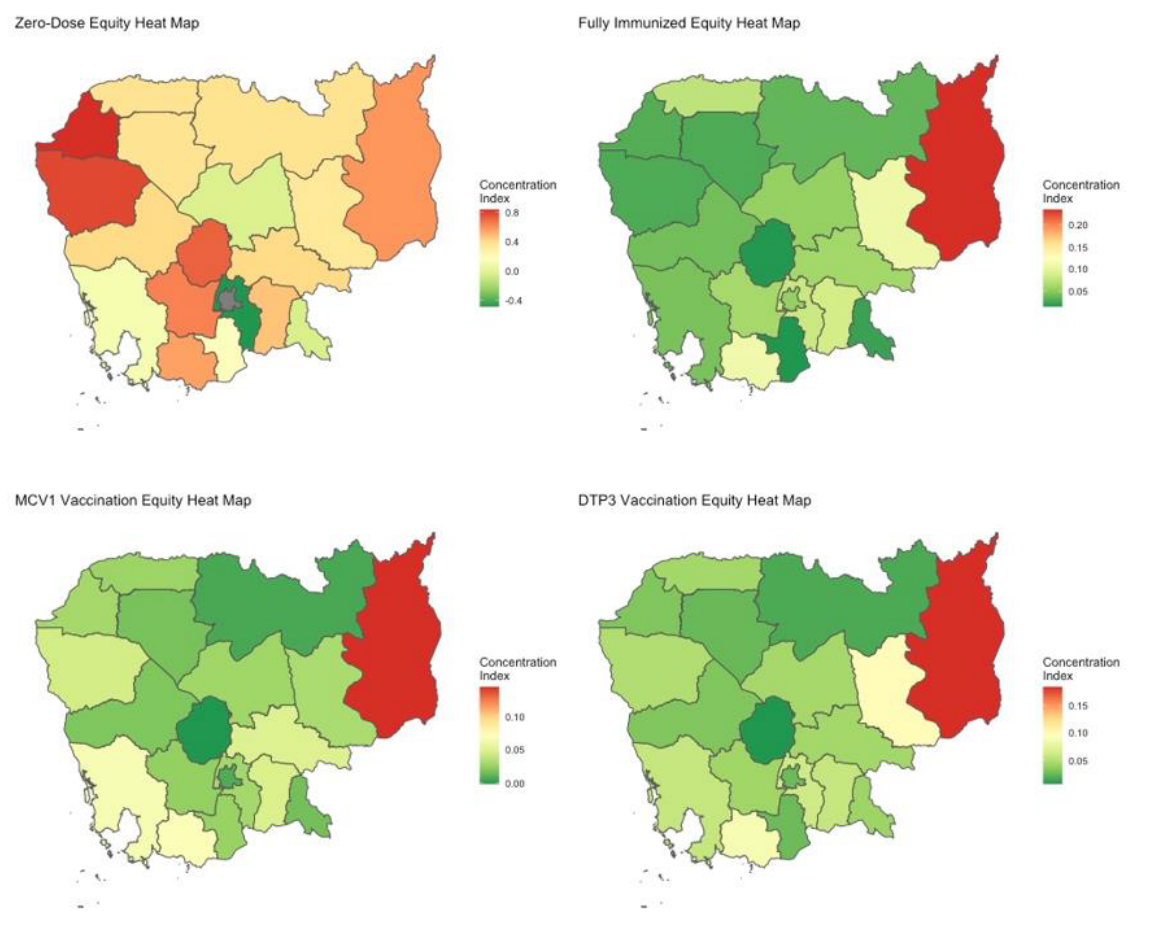
Figure 3. Heat maps of relative extent of equity, using the composite Wagstaff CI, for ZERO, FULL, MCV1, and DTP3 for survey year 2014. Spatial divides represent individual or pairs of Cambodia’s administrative districts.